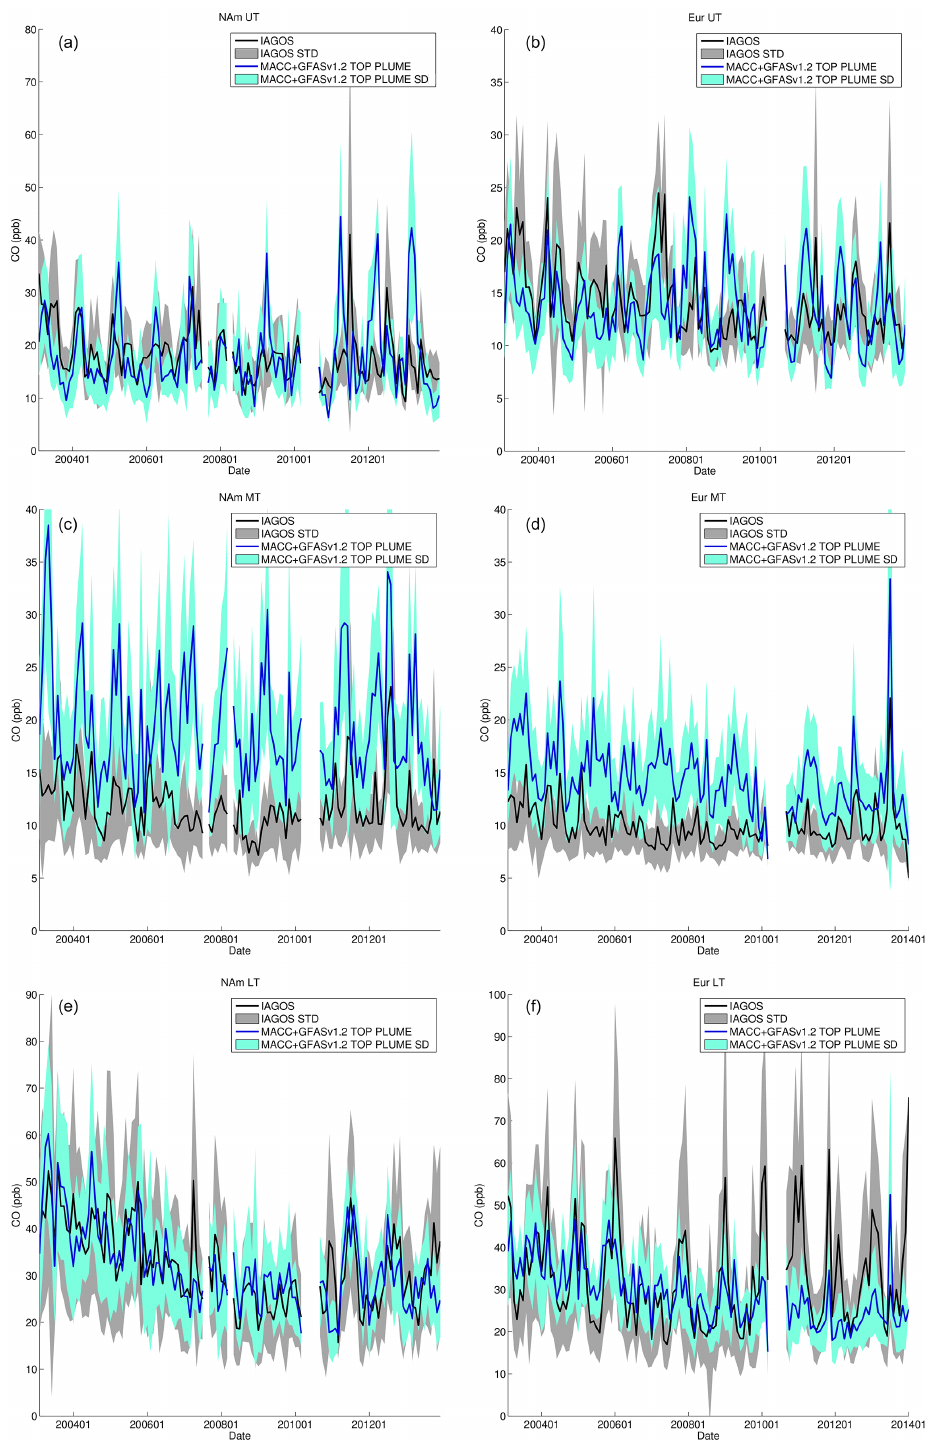
Figure 11. Times series (monthly means between 2003 and 2013) of the observed (black) and simulated (blue) plumes of CO enhancements for the two most documented regions (North America and Europe) in the LT (e, f) , MT (c, d) and UT (a, b) , using MACCity and GFAS v1.2. Standard deviations are in gray (observations) and light blue (SOFT-IO). Biomass burning vertical injection uses APT